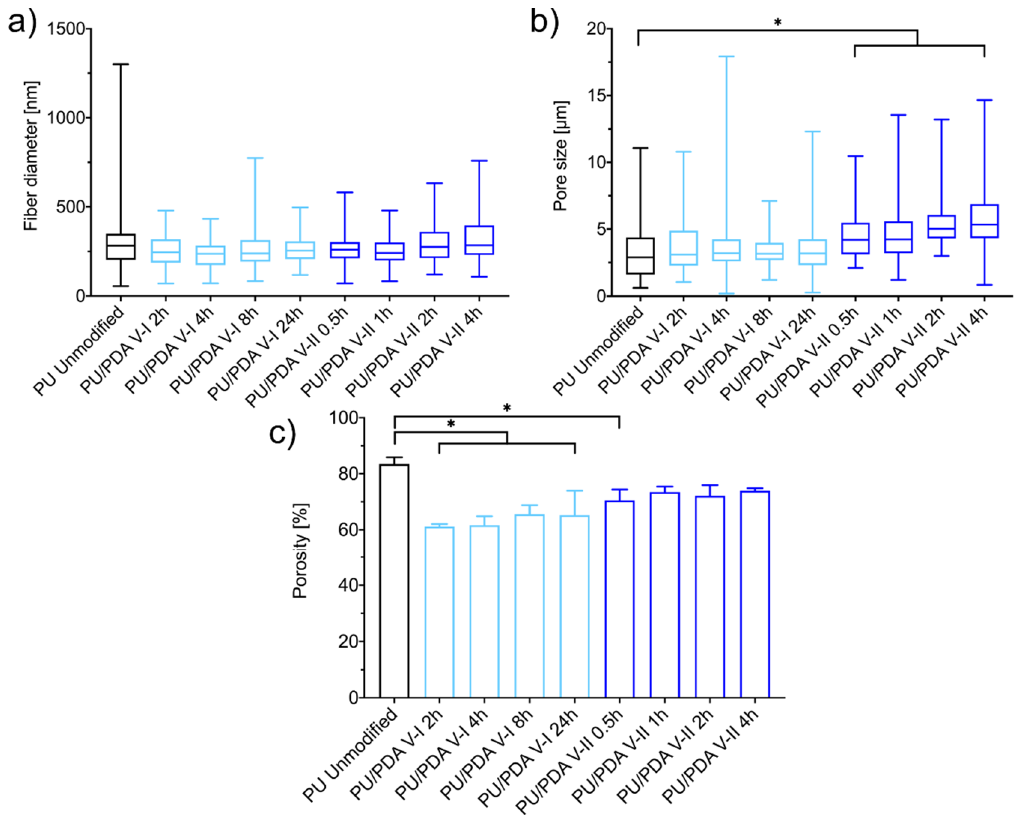
Figure 3. ( a ) size distributions, ( b ) pore size distributions, and ( c ) porosity of unmodified and modified PU nanofibrous materials. The asterisk (*) denotes a significant ( p < 0.01) difference among the mean value of the characteristics of nanofibrous materials.